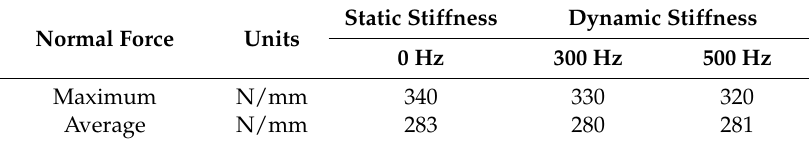
Table 5. Maximum and average normal forces in contact patterns when torque is 140 Nm.